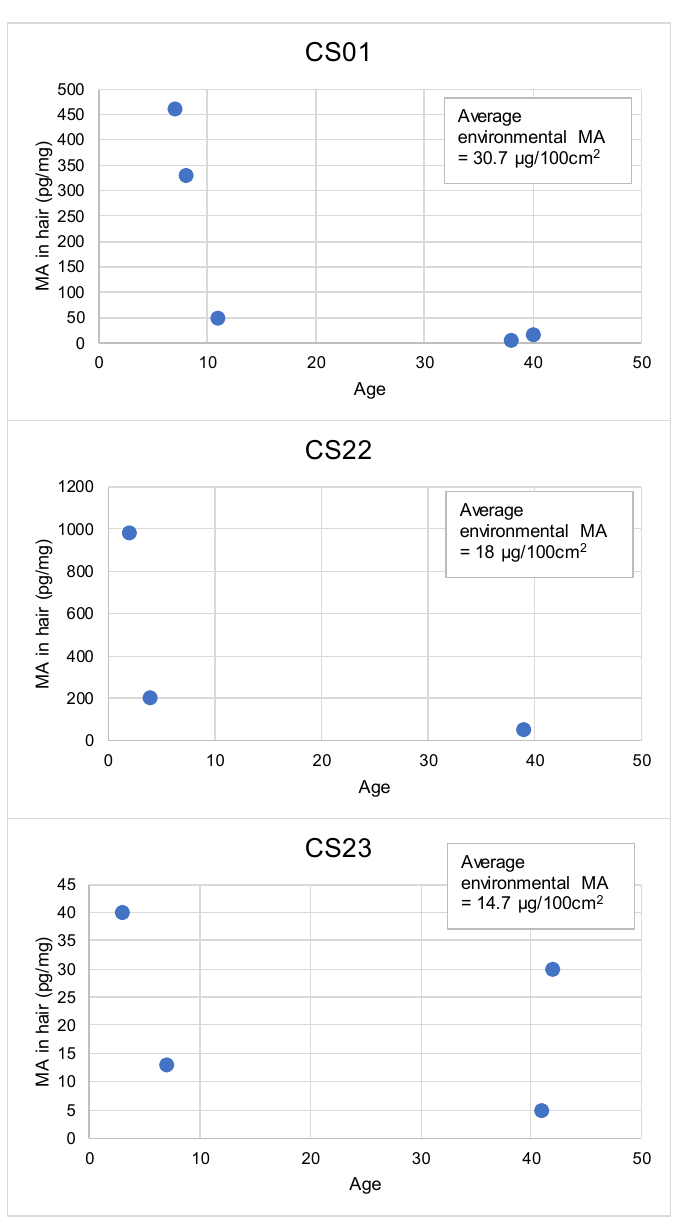
Figure 2. Methamphetamine levels (pg/mg) in hair for families from three case studies (note different scale on the y axes).